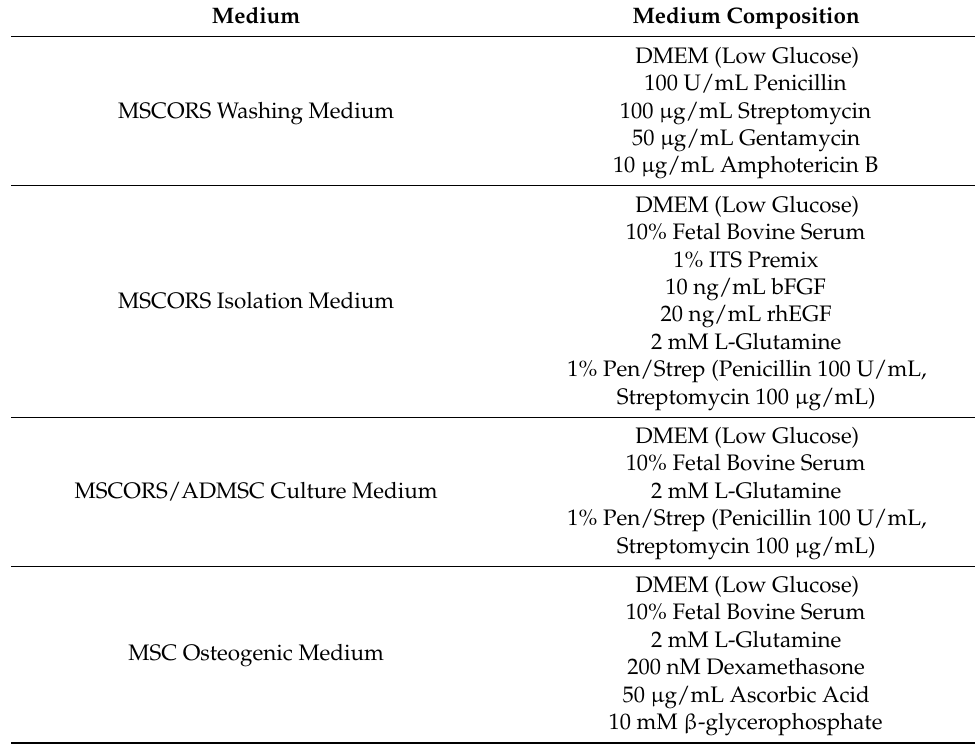
Table 1. Medium compositions for cell